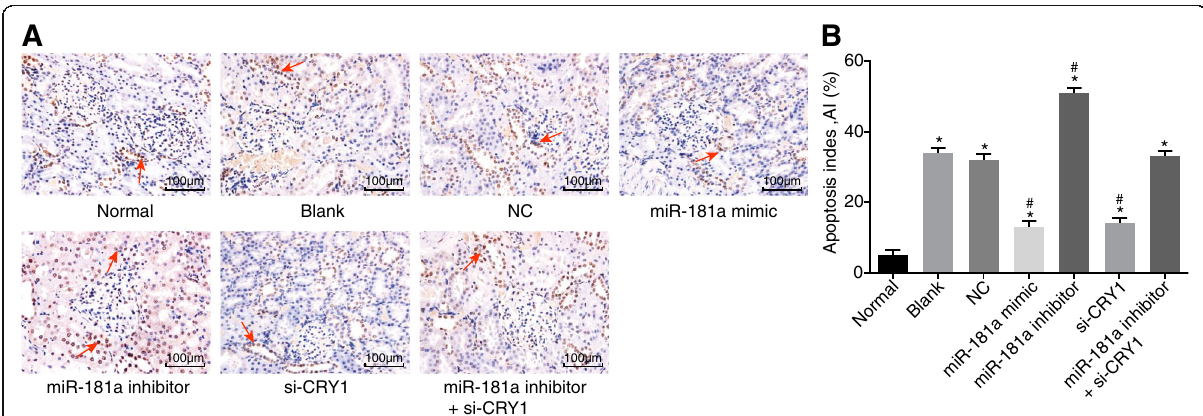
Fig. 7 TUNEL staining indicates that RTE cell apoptosis is inhibited by overexpression of miR-181a or down-regulation of CRY1 (× 200). Notes: Panel a , results of TUNEL staining under a microscope; Panel b , histogram of TUNEL staining results; * , p < 0.05 vs. the normal group; # , p < 0.05 vs. the blank and NC groups; the data are presented as the mean ± standard deviation, analyzed by one-way ANOVA; the experiment was independently repeated three times; NC, negative control; miR-181a, microRNA-181a; CRY1, cryptochrome